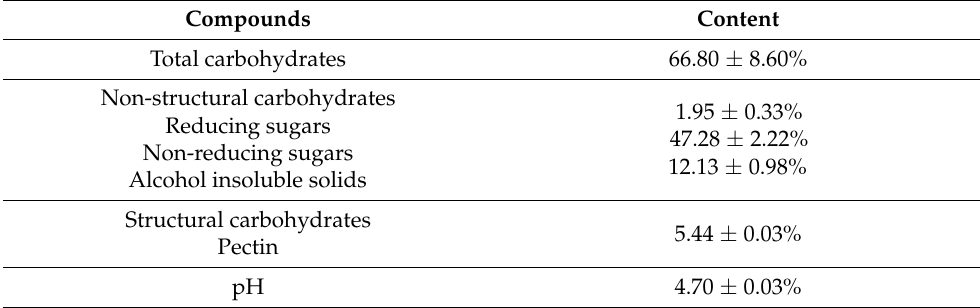
Table 1. Content of total, non-structural (reducing and non-reducing sugars and, alcohol insoluble solids), and structural (pectin) carbohydrates, and the pH of Nopalea cochenillifera fresh matter.